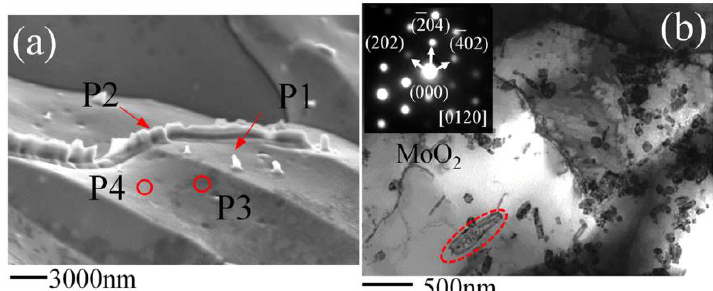
Figure 2. ( a ) SEM image of the fracture of Mo joint with plenty of MoO 2 at grain boundary, and ( b ) TEM bright field image of the weld bead of the Mo joint [10].